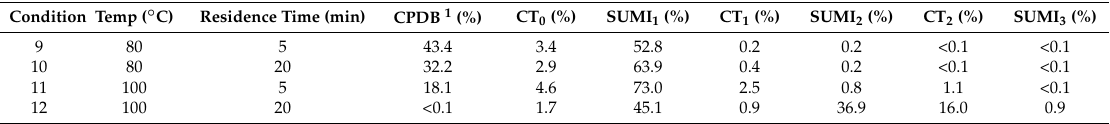
Table 2. Online screening results for CPDB RAFT polymerization reactions with 5 equivalents of the monomer n -butyl acrylate and 0.25 equivalents of the thermal initiator AIBN. Condition